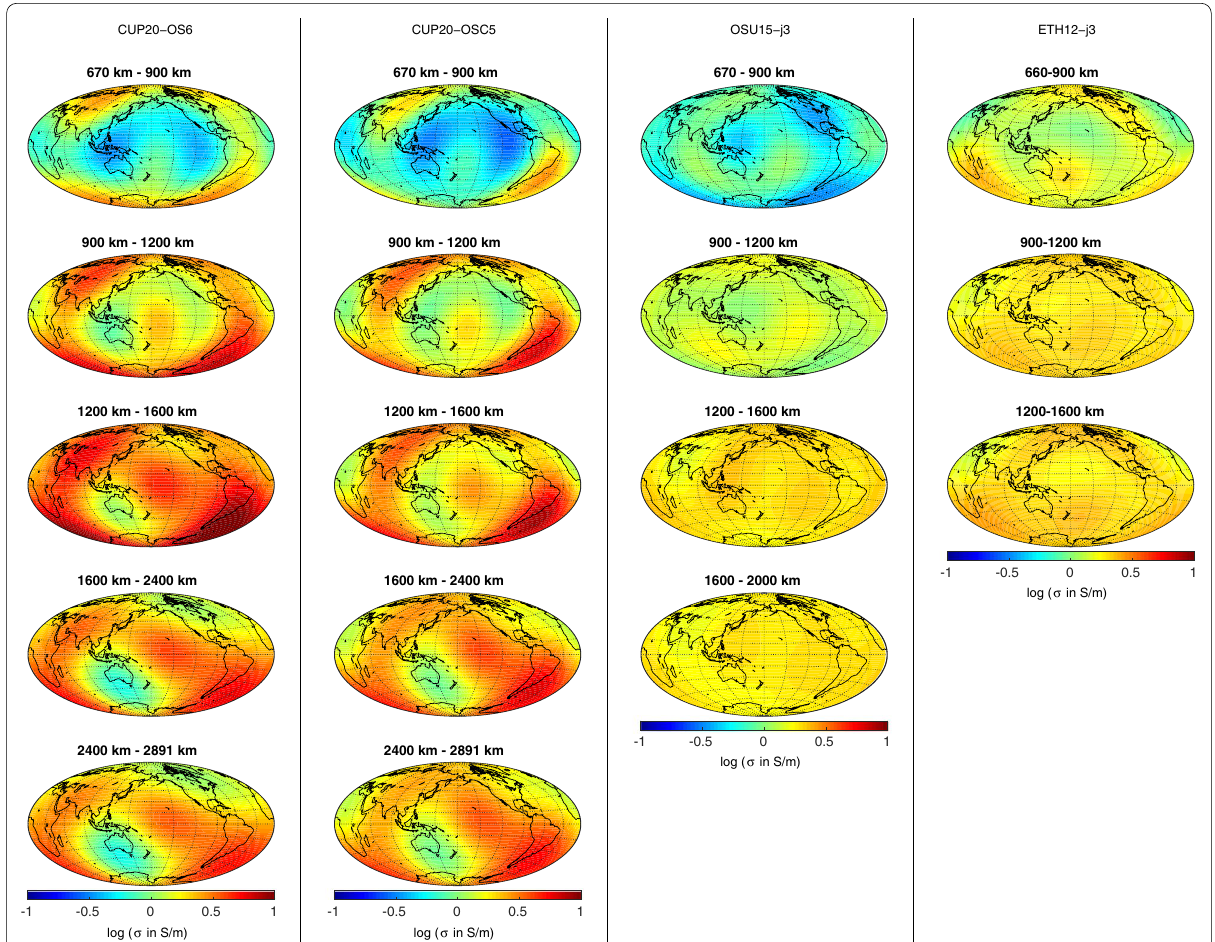
Fig. 6 Cross-sections of electrical conductivity models CUP20-OS6, CUP20-OSC5, OSU15-j3, and ETH12-j3 in the lower